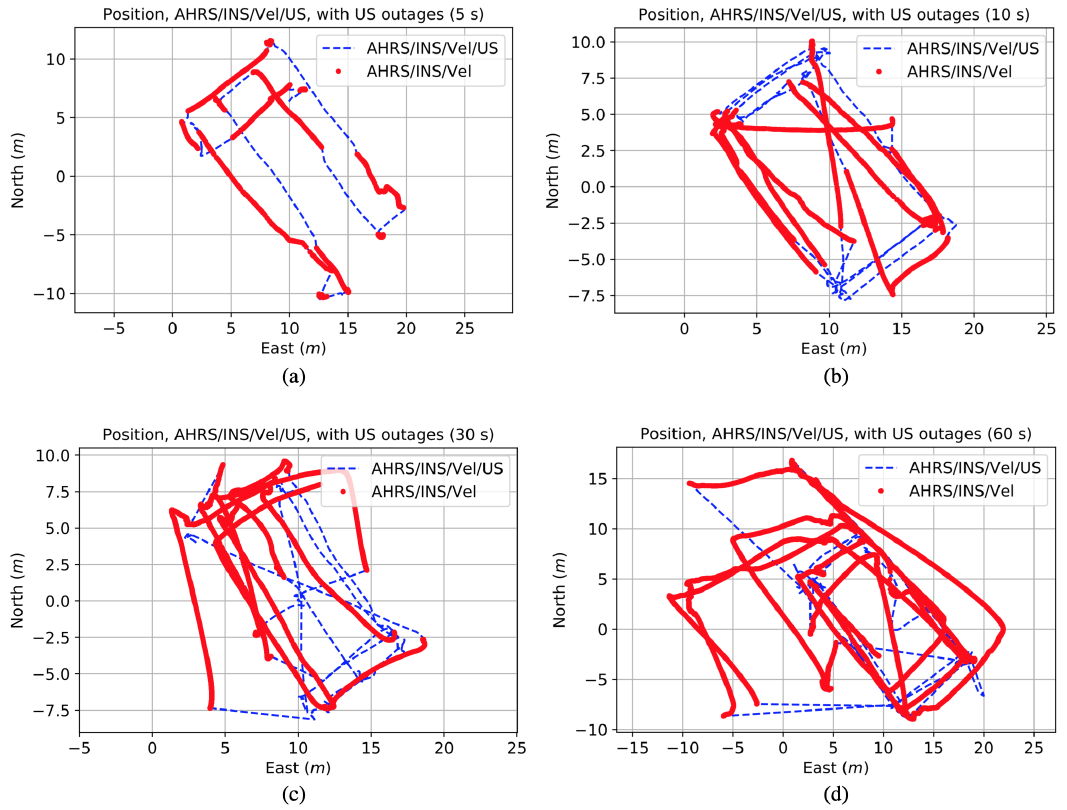
Figure 11. 2D position results by processing four test data with US outages of ( a ) 5 s, ( b ) 10 s, ( c ) 30 s, and ( d ) 60 s,